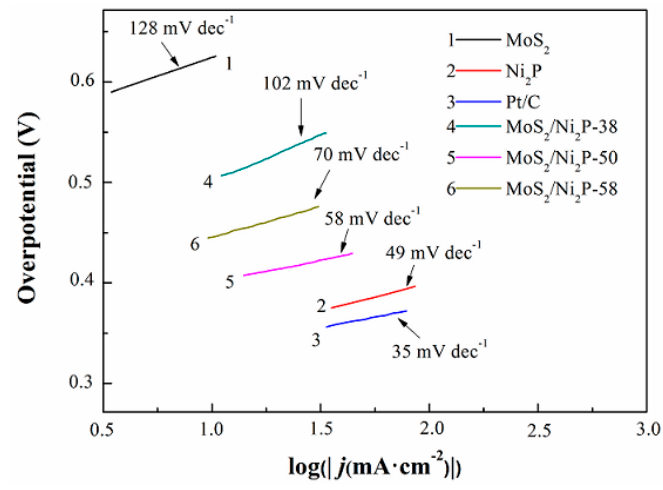
Figure 6. Tafel plots of MoS 2 , Ni 2 P, three MoS 2 /Ni 2 P hybrids, and commercial 20 wt % Pt/C. Scan rate: 2 mV/s, potential window: 0.3~0.65 V.